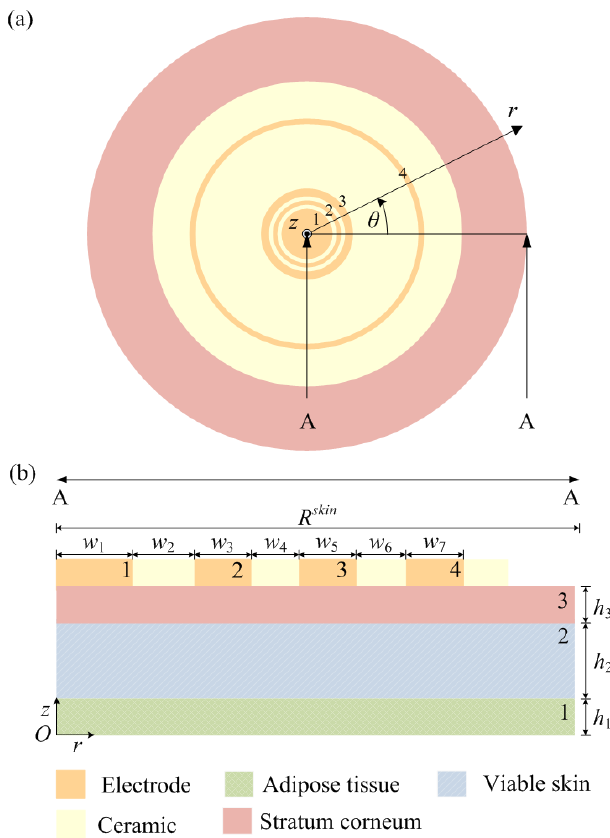
Fig. 3: Schematic of a 4-electrode probe and skin modeled as a three-layer